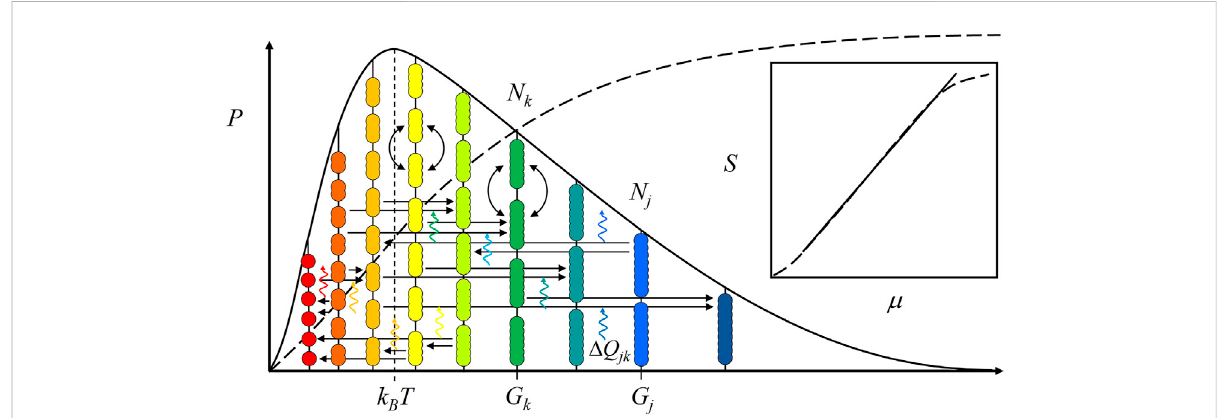
FIGURE 1 General energy-level diagramrepresents anysystemcomprisingquanta.Entitiesinnumbers, N k , ofthesameenergy, G k , relativetotheaverage energy, k B T , are on the same level. While their mutual exchange (bow arrows) causes no change, the system evolves toward balance with its surroundings through transformations (horizontal arrows) where quanta with energy, Δ Q jk , (wavy arrows) absorb into products, N j , or emit from starting materials, N k . The logarithm of the sigmoid, cumulative probability, P , (dashed line) is entropy, S = k B ln P . Inset: On the log – log scale, S vs. potential energy, μ , mostly follows a power law, i.e., a straight